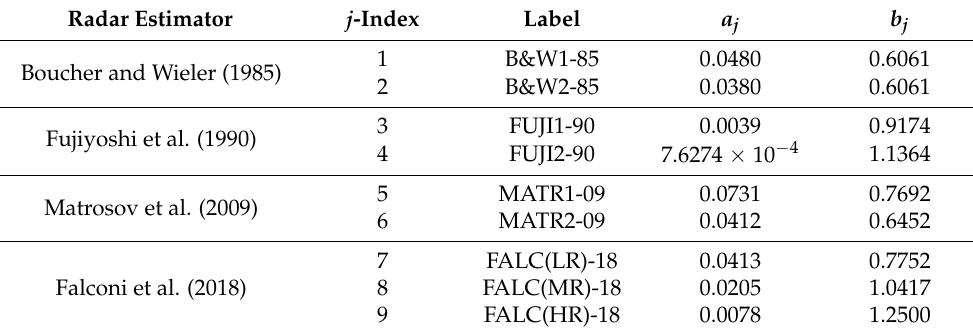
Table 5. List of X-band radar-based estimation algorithms for snow retrievals. For each estimator, the coefficients a j and b j used in Equation (2) to estimate the snowfall rate ( SR ) in mm · h − 1 from the horizontal reflectivity Z h in mm 6 · m − 3 are shown. The algorithms developed in [64] refer to different riming conditions, i.e., low riming (FALC(LR)-18), moderate riming (FALC(MR)-18) and heavily riming (FALC(HR)-18). Adapted from [55]. Radar Estimator j